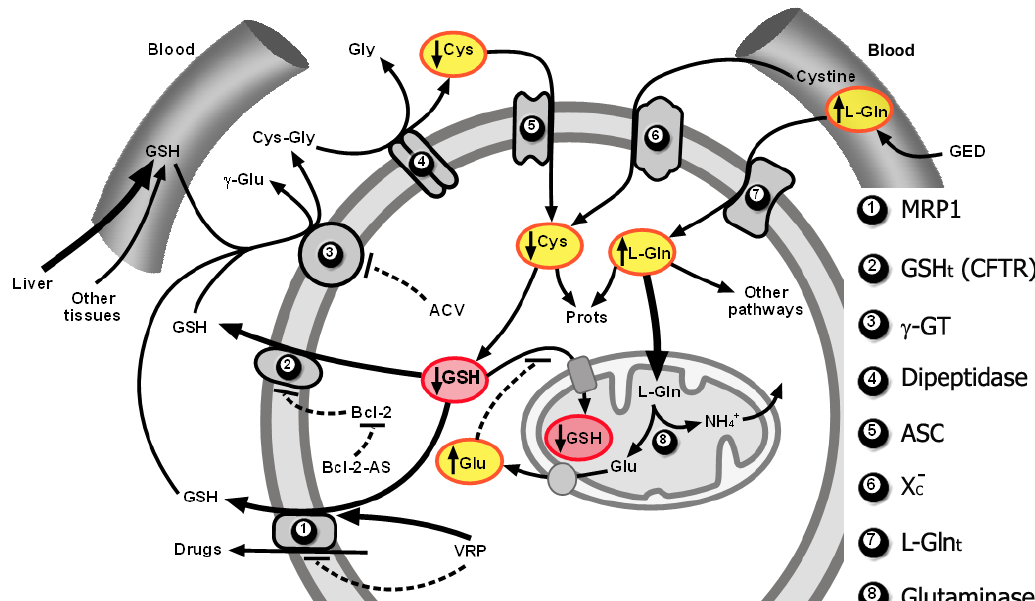
Figure 2. Experimental therapy to deplete GSH levels in cancer